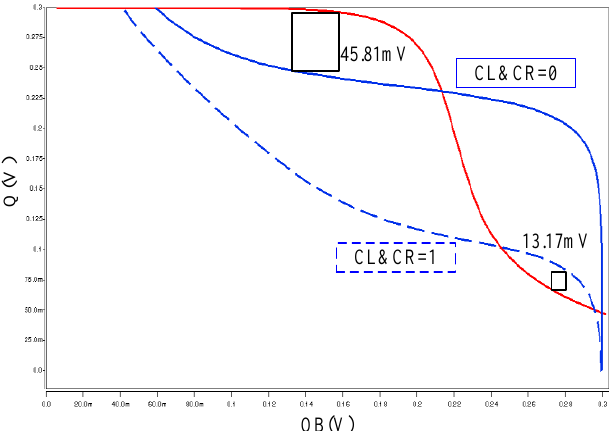
Figure 6. RSNM of proposed 10T cell.